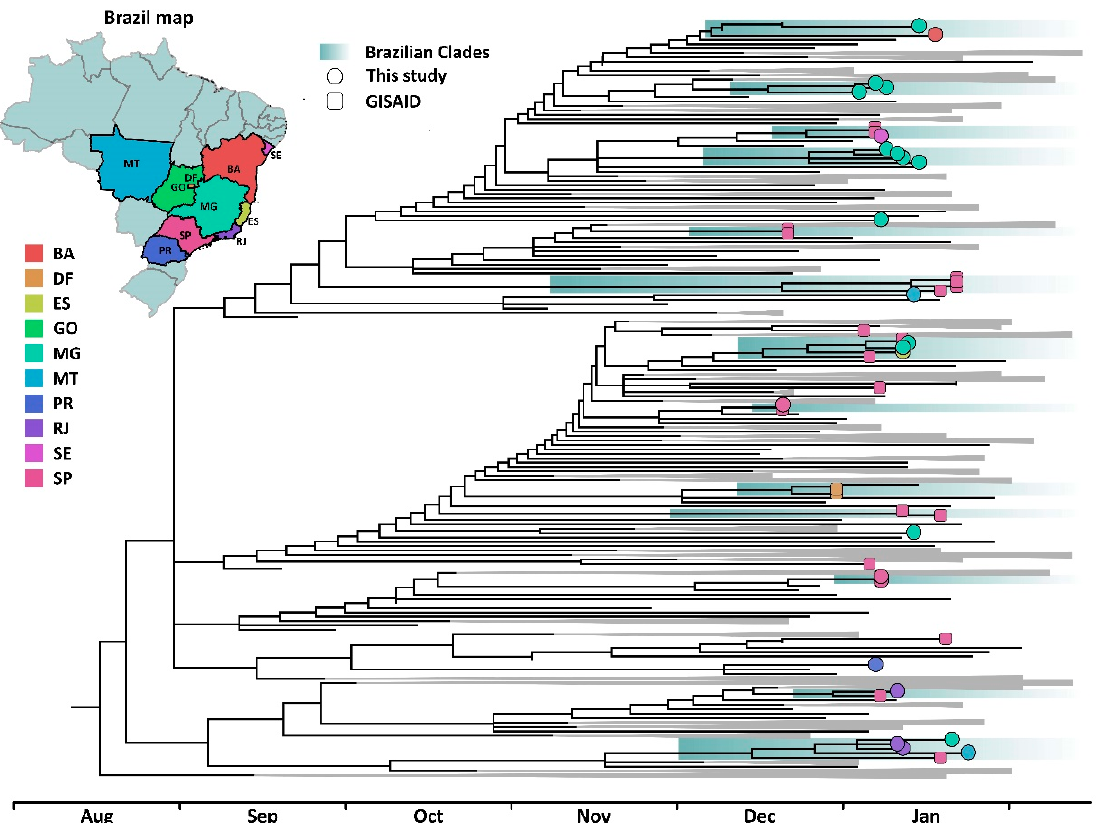
Figure 1. Time scaled phylogenetic tree inferred from a dataset comprehending 406 publicly available B.1.1.7 sequences and the 25 new genomes characterized in this study. Brazilian sequences are color coded according to original federal states and tip shapes mark new and previously described genome sequences. Brazilian clades are shaded in green. The tree supports that multiple introductions occurred in different regions of the country between early December 2020 and early January 2021. While some introductions are related to single sequences, others are linked with the emergence of clades, emphasizing the occurrence of local transmission in the country. Trees inferred in this study are available on https://github.com/filiperomero2/SC2_lineage_B.1.1.7_in_Brazil (ac- cessed on 24 May 2021).